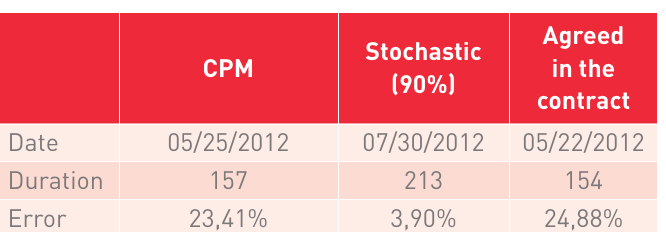
Forecast compared against the actual performance of the project